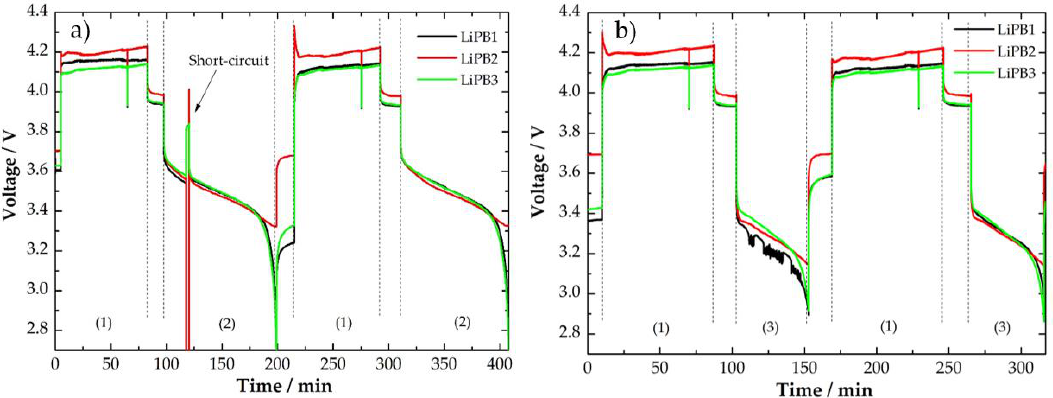
Figure 3. Voltage dependence with time for each LiPB, ( a ) at 0.7 C discharge rate and ( b ) at 1.4 C discharge rate. (1) Constant current (CC) charge at 1.0 C; (2) CC discharge at 0.7 C; (3) CC discharge at 1.4 C.